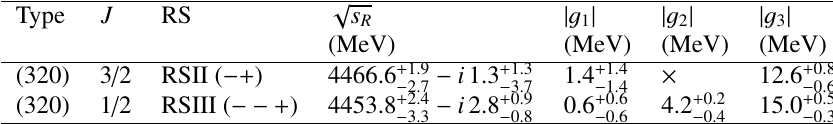
Table 9. The poles for the fit (320) with three